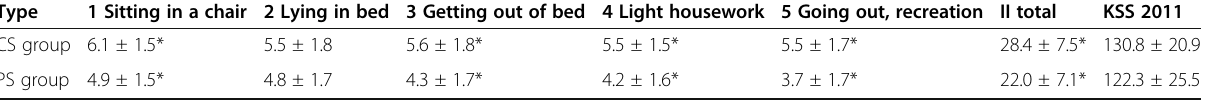
Table 4 Comparison of satisfaction with each item and the total KSS 2011 at 1 year after surgery